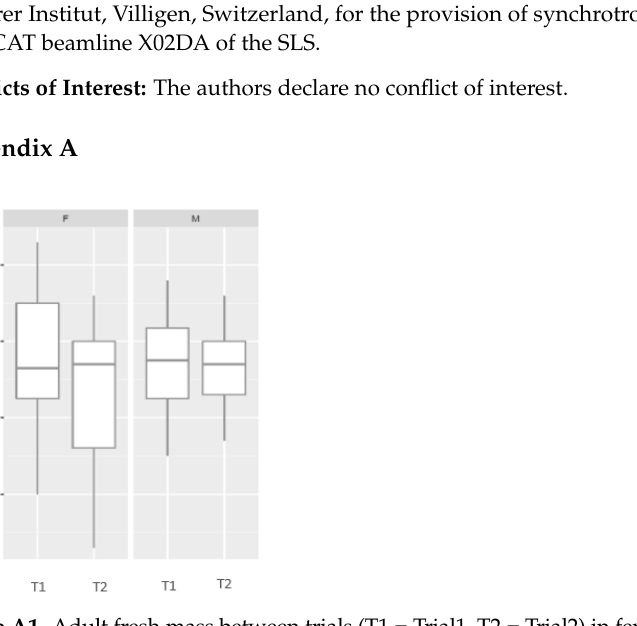
Figure A2. The relationship between club area and antennal stalk length in females (red circles) and males (blue triangles) of Pieris napi . References 1.